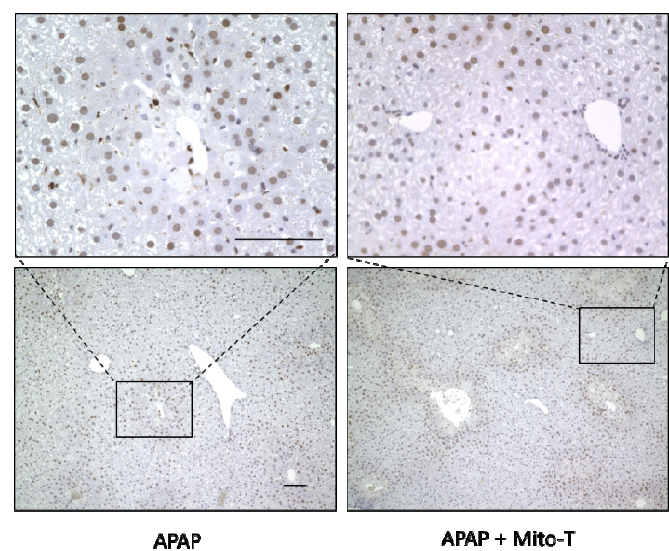
Figure 5. Effect of Mito-T on proliferating cell nuclear antigen (PCNA) expression. Mice were treated with Mito-T (20 mg/kg, i.p.) or saline 12 h after APAP (400 mg/kg, i.p.) administration. Liver tissue samples were collected 24 h after APAP injection. Representative PCNA staining of the hepatic sections in mice. Scale bar: 100 μ m.